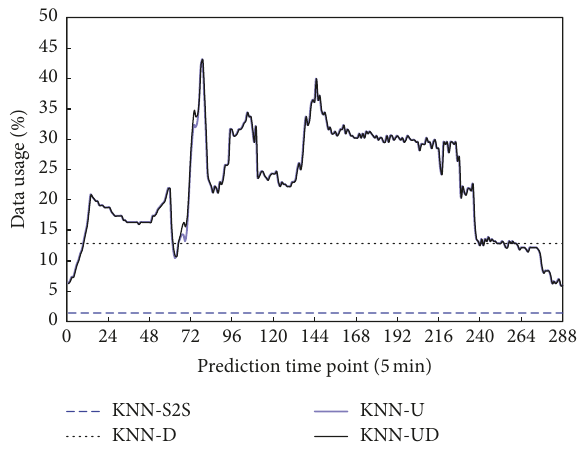
Figure 6: Data usage according to prediction time